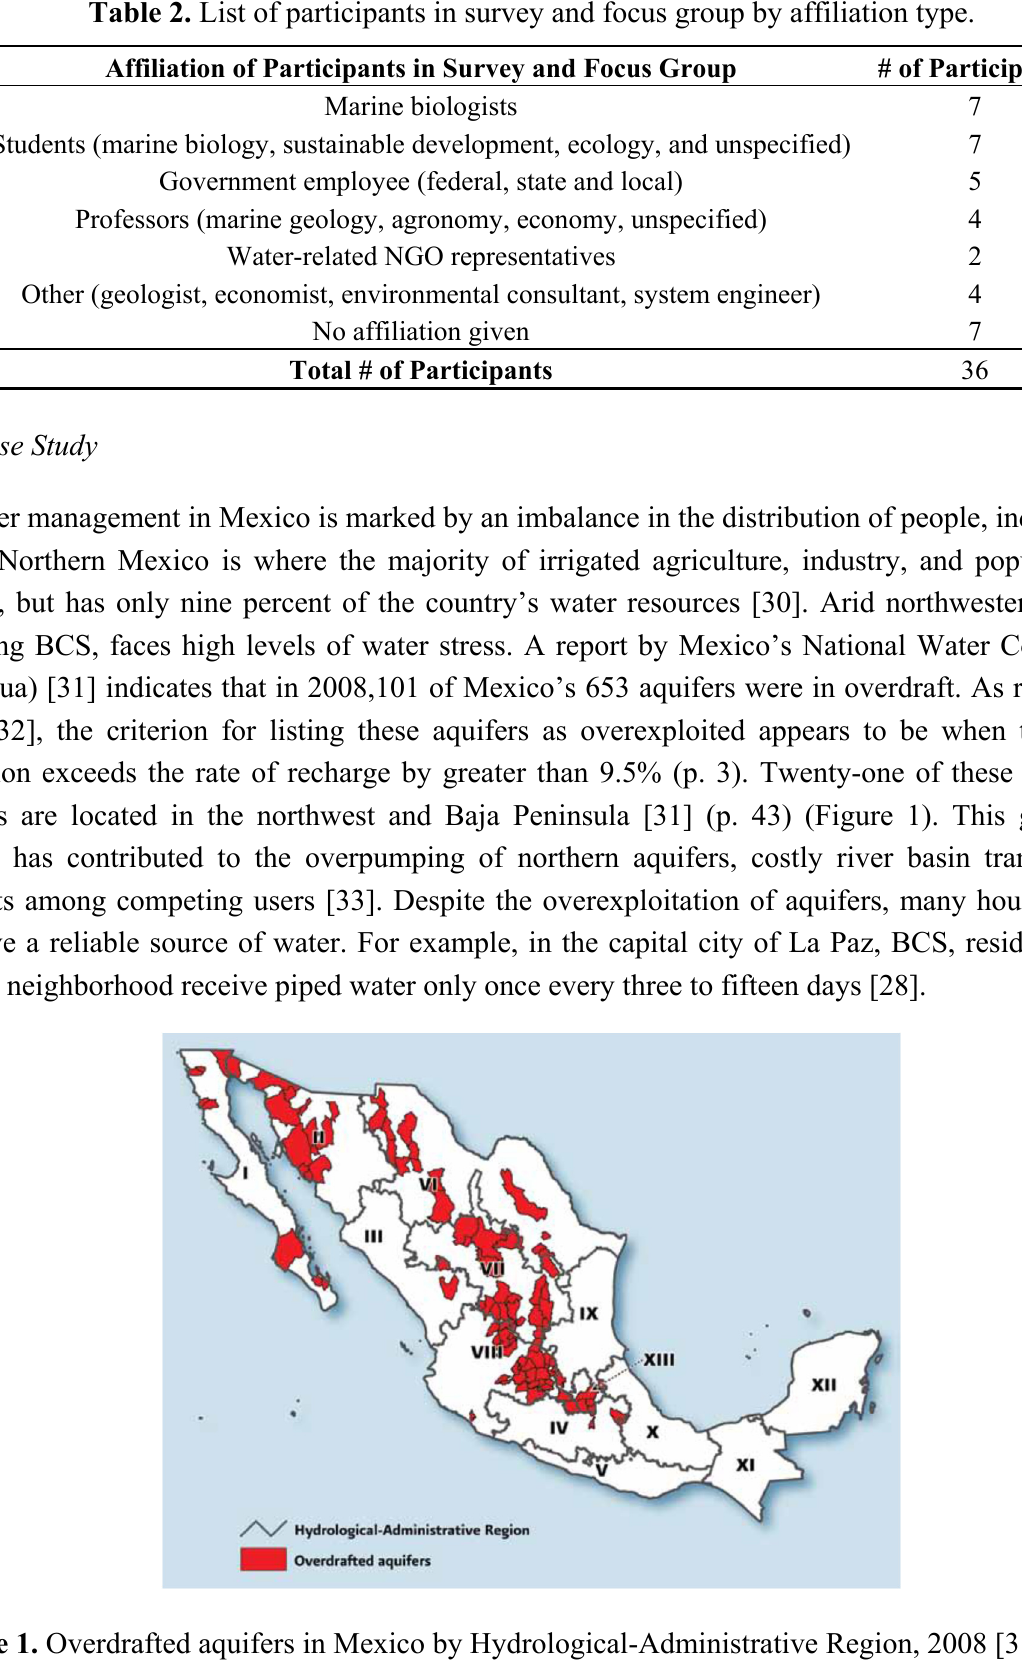
Figure 1. Overdrafted aquifers in Mexico by Hydrological-Administrative Region, 2008 [31] (p.